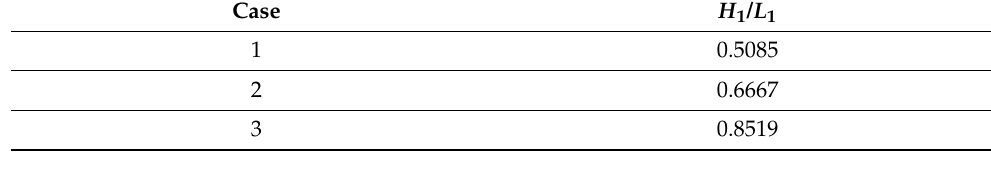
Figure 4. Diagram of the Constructal Design method applied to the problem.